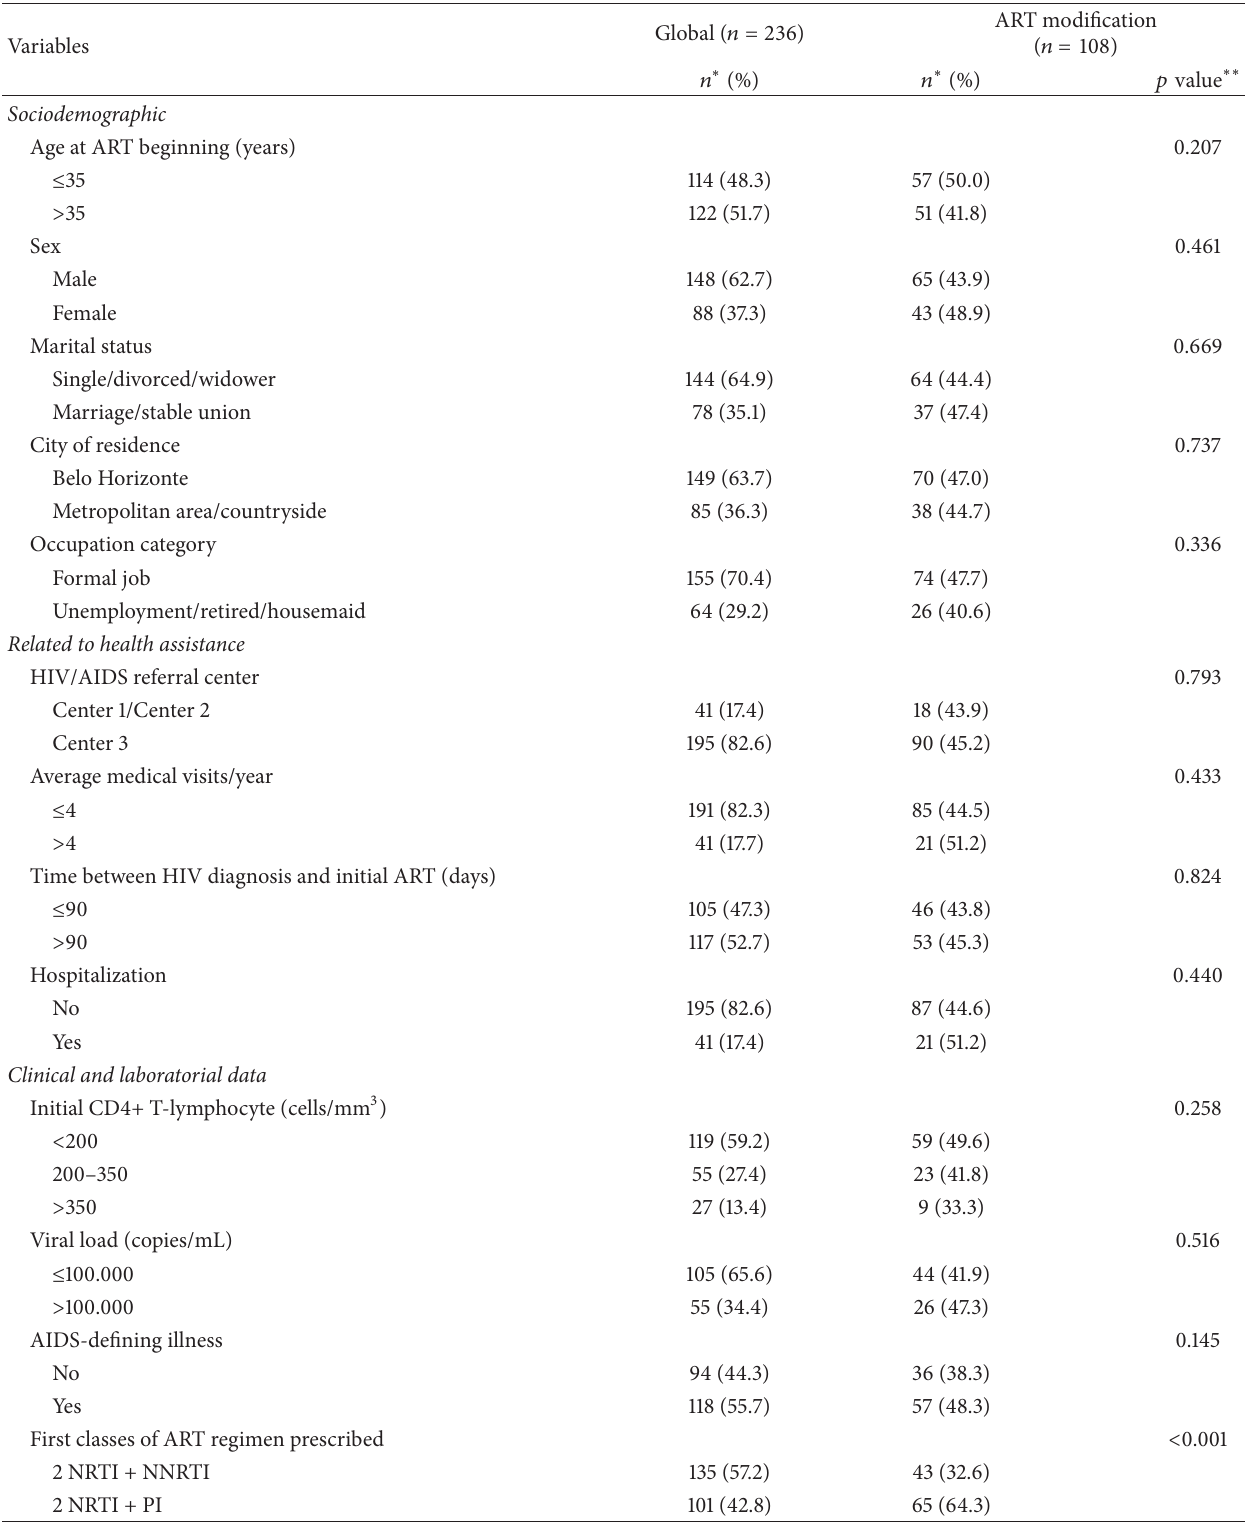
Table 1: Baseline characteristics of the HIV/AIDS patients from the historical cohort, Belo Horizonte,